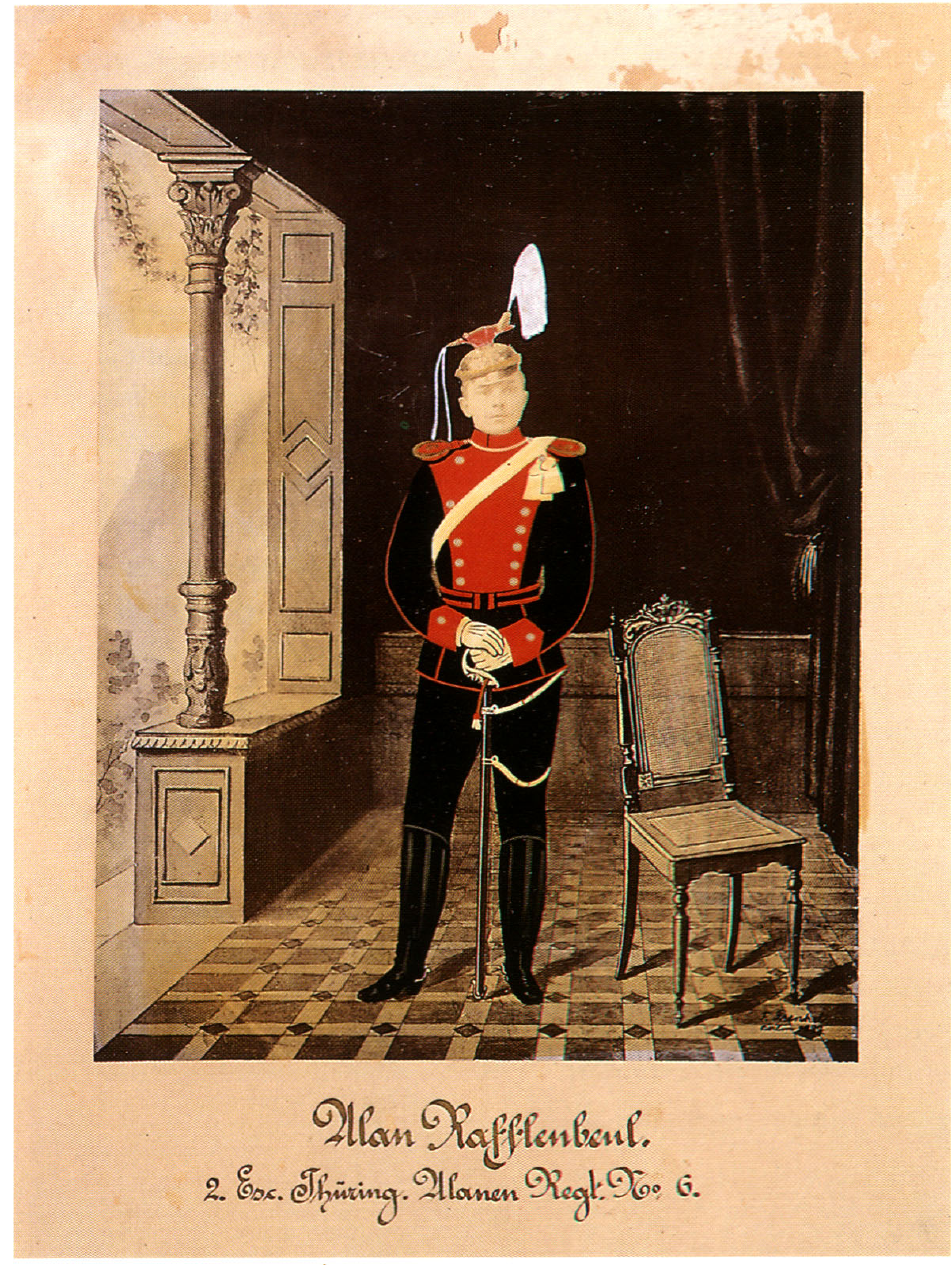
Figure 1 F. Frenkel, Ulan Raffenbeul, 2. Escorte Thüringisches Ulanen Regiment Nr. 6 , Berlin (Lancer Raffenbeul, 2 nd Escort of the Thüringen Lancer Regiment, Nr. 6, Berlin). 1899. Silver chloride gelatin photograph with paint and collaged photograph. Collection of the Museum Folkwang, Essen. 40.7 x 32